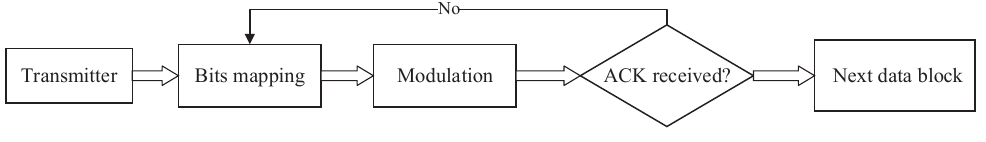
Figure 1. Transmission model of the